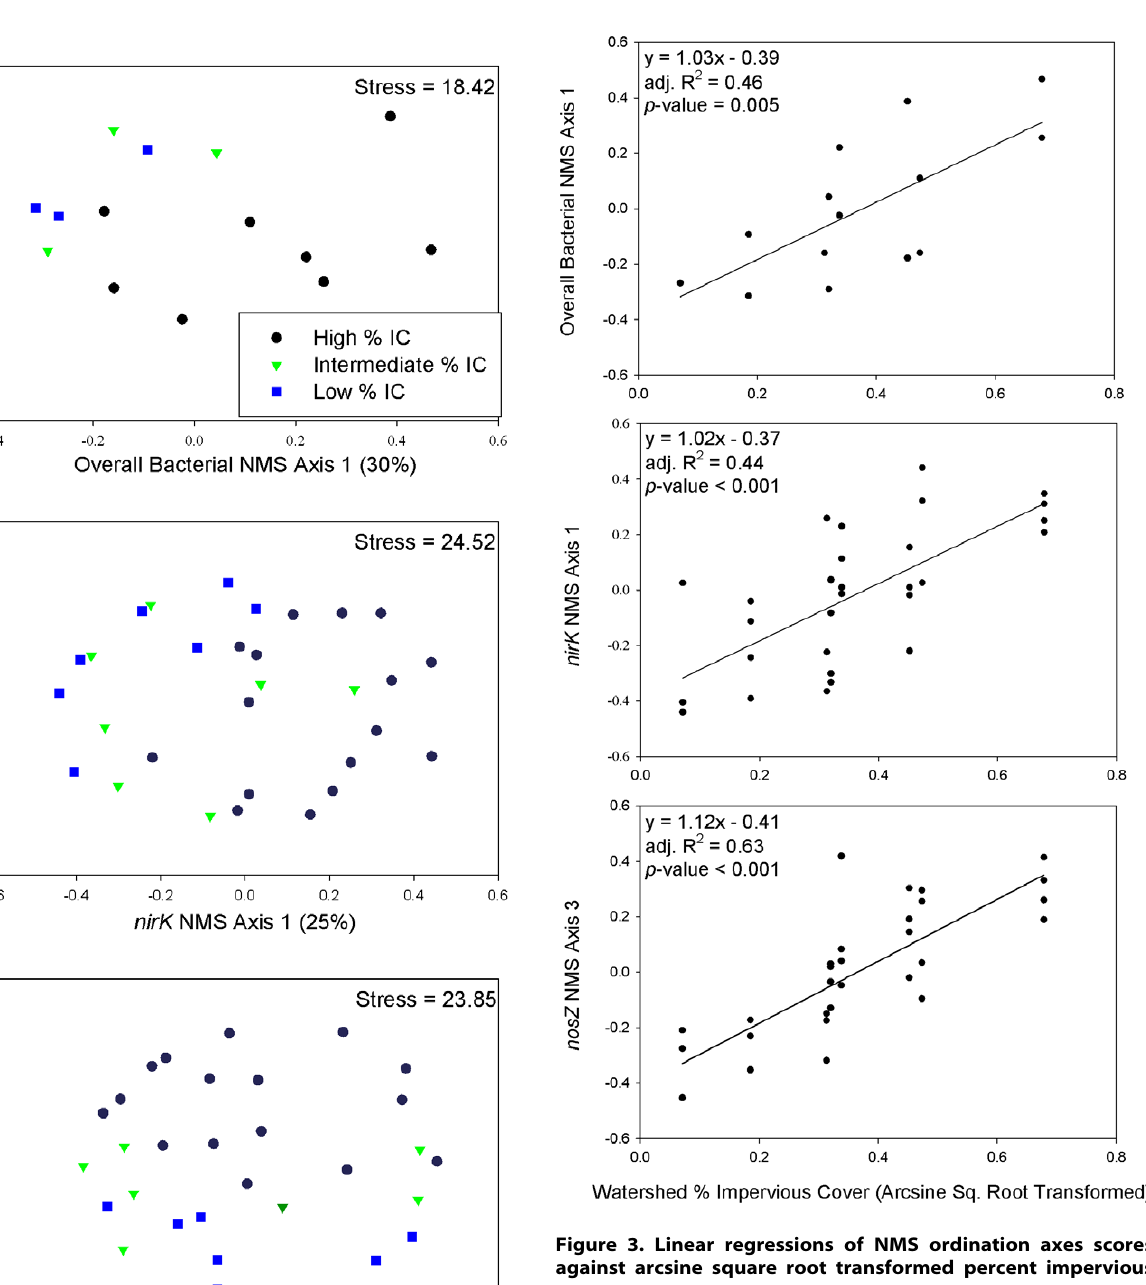
Figure 3. Linear regressions of NMS ordination axes scores against arcsine square root transformed percent impervious cover.